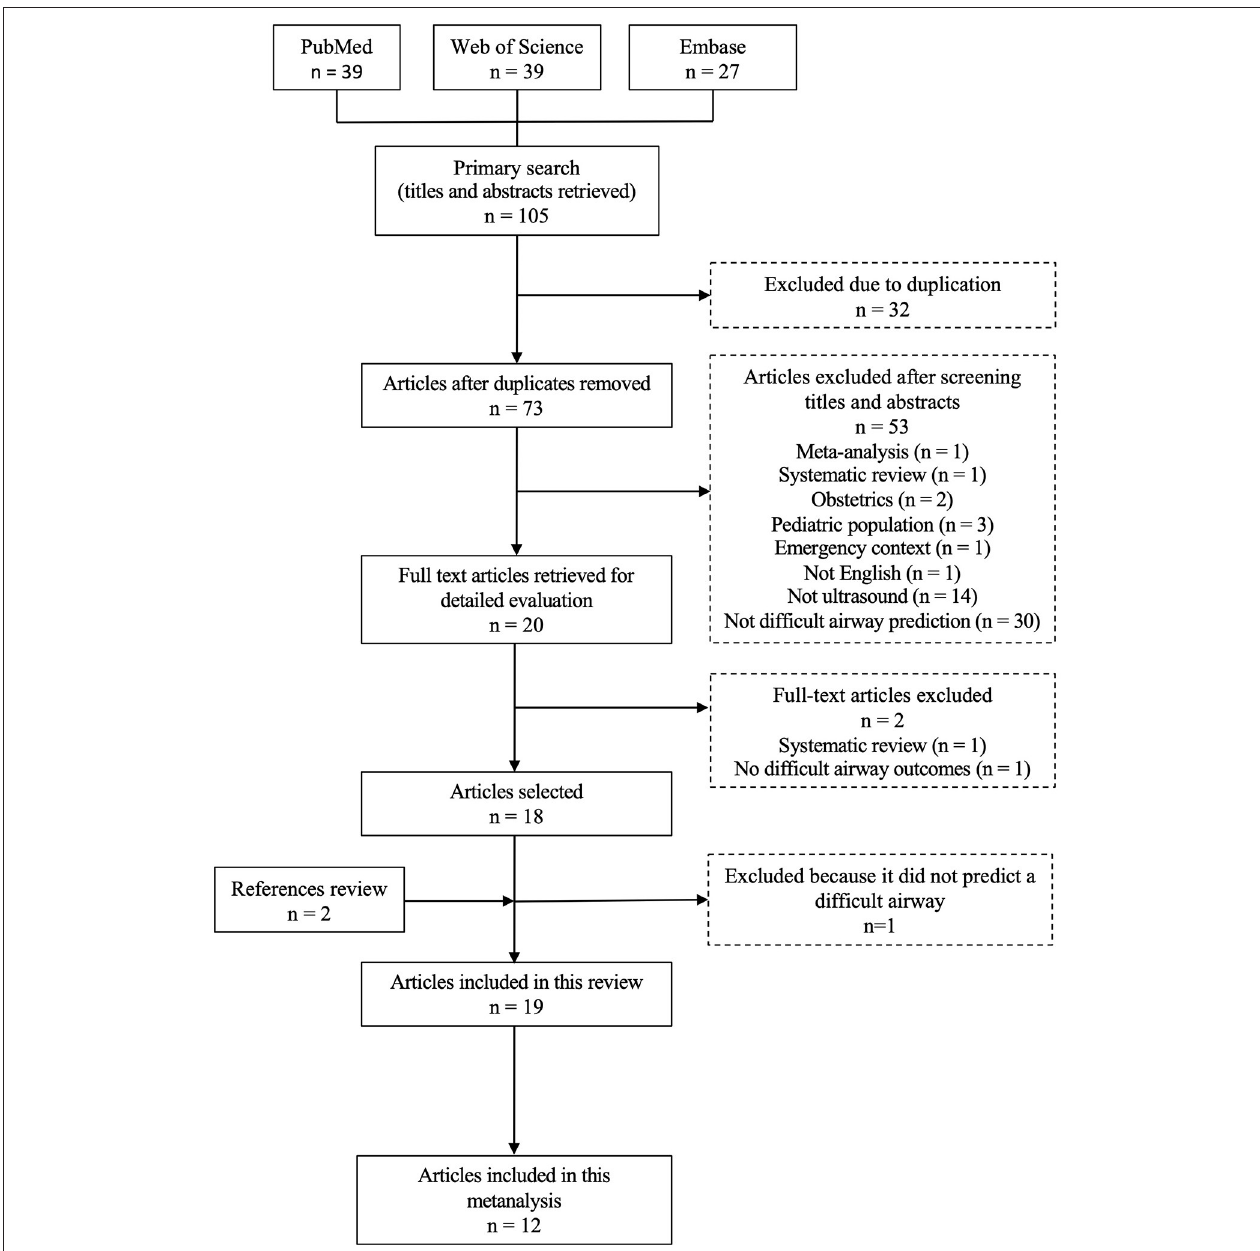
FIGURE 1 | PRISMA methodology flowchart for article